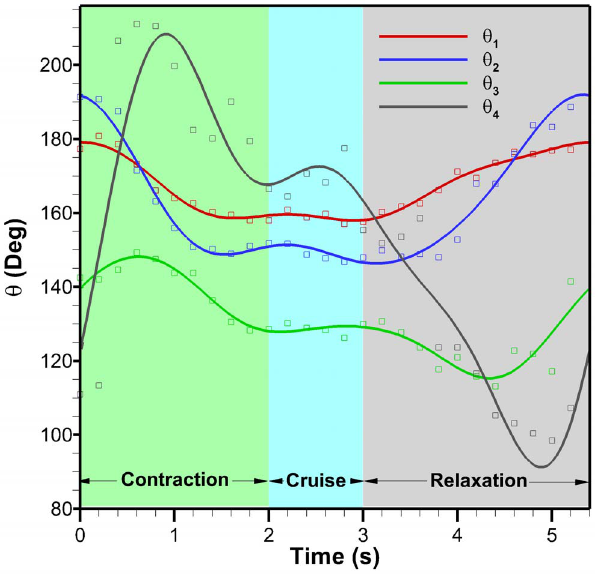
Fig. 10. Segment angles as a function of time. Angles between adjacent segments of the four-segment anatomical model over a full cycle. Squares represent the four-segment anatomical model and lines represent the four-segment anatomical Fourier